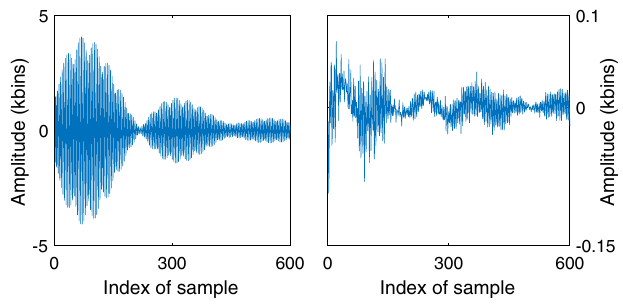
FIG. 11. Fitting waveform (left) and the difference between it and the original signal (right). The coefficient of determination ( R 2 ) is over 0.99 and the RMS error of the difference waveform is 0.019 kbins, which is similar to the result in Fig. 9.